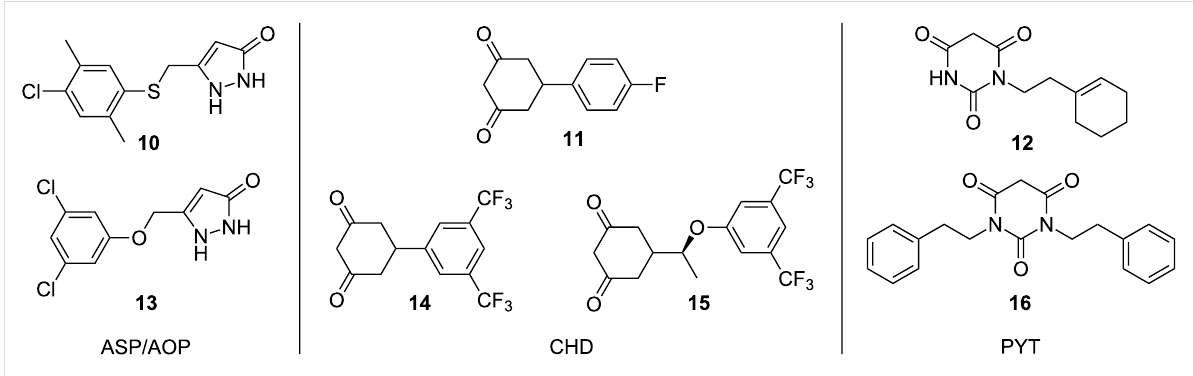
Figure 6: Families of compounds (named in italics) capable of reducing SOD1-induced cellular toxicity and mutant SOD1 protein aggregation. Top: selected compounds identified in high-throughput screening. Bottom: advanced compounds.